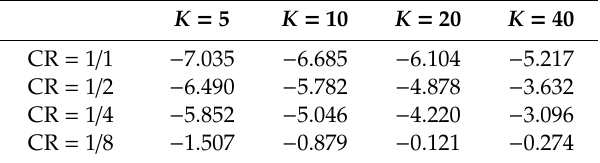
Table 3. SDDs under di ff erent sparsity levels and compression ratios (dB).